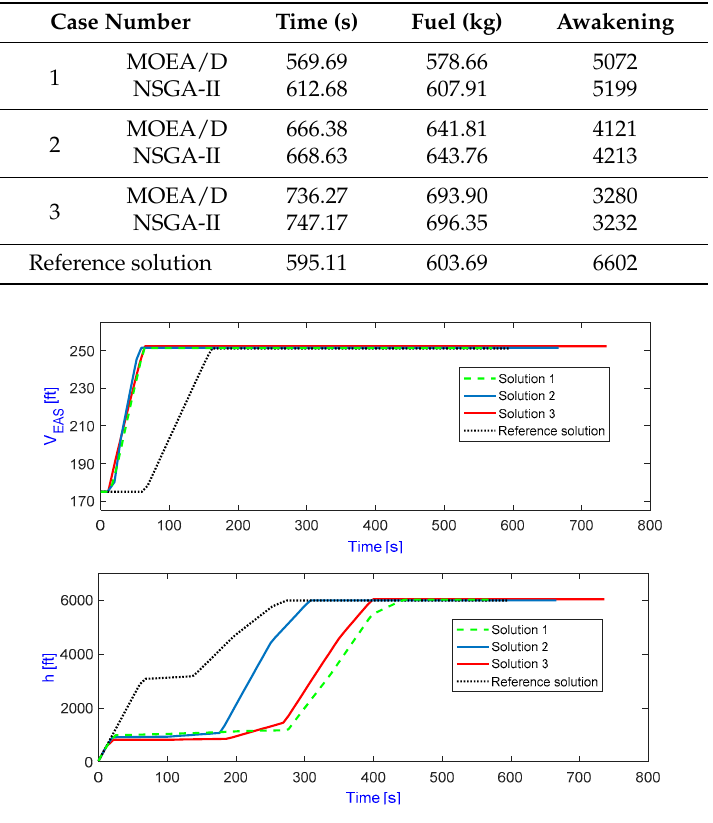
Figure 5. Vertical profiles of cases 1–3, and the reference case.